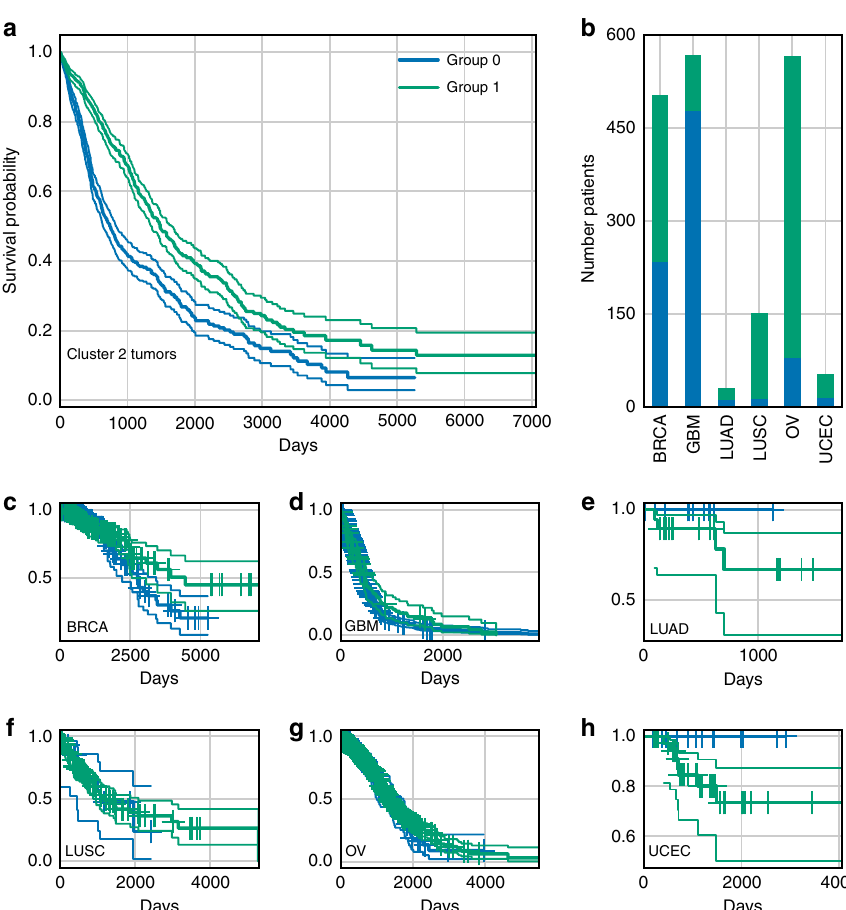
Fig. 3 Gene signature and survival outcome. Kaplan – Meier survival curves for two groups of patients obtained via k-mean clustering of expression levels of cluster 2 signature genes. a Plot of the survival curves for worse (group 0) and better (group 1) outcome patient groups of all cluster 2 tumours, with a 95% con fi dence interval (group 0: 790 observations, 362 censored; group 1: 1094 observations, 648 censored; log-rank test p -value: 7.26 × 10 − 18 ). b Distribution of group 0 and group 1 patients inside cluster 2 tumours, showing a fairly homogeneous distribution of samples (see Supplementary Table 10 for further discussion). c – h Kaplan – Meier survival curves for groups 0 and 1 considering each tumour